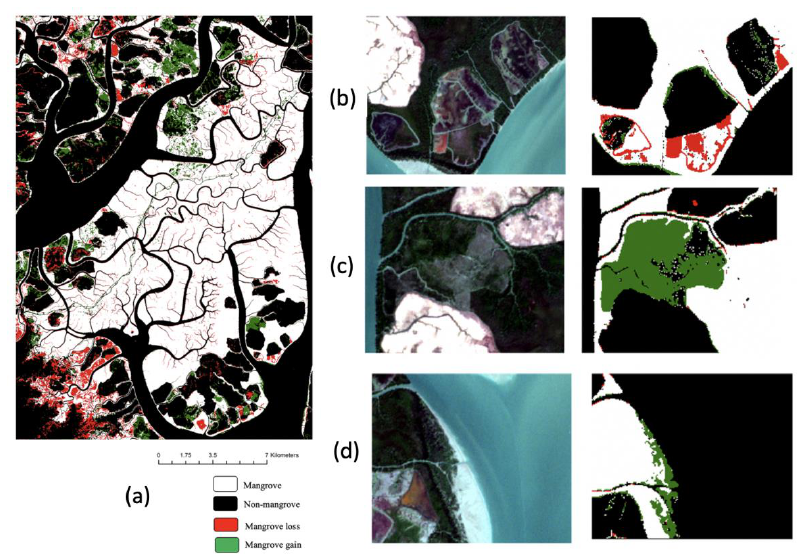
Figure 15. ( a ) Change detection result of Wunbaik Mangrove Forest (WMF), ( b ) Mangrove loss area due to shrimp pond expansion, ( c ) Mangrove gain area in artificial plantation, and ( d ) Mangrove gain area through natural regeneration.